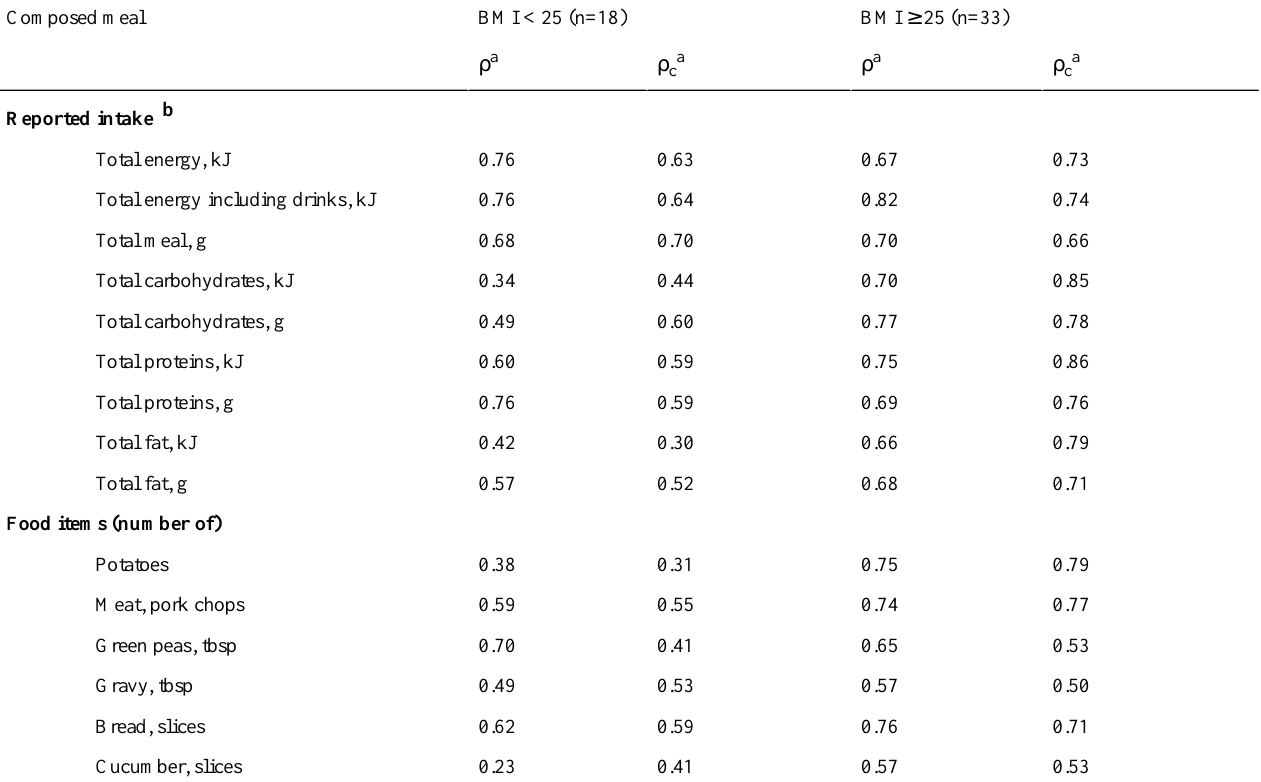
Table 5. Spearman rank correlations ( ρ ) and concordance correlation coefficients ( ρ c ) between participants’ composed meals using the two meal instruments by body mass index